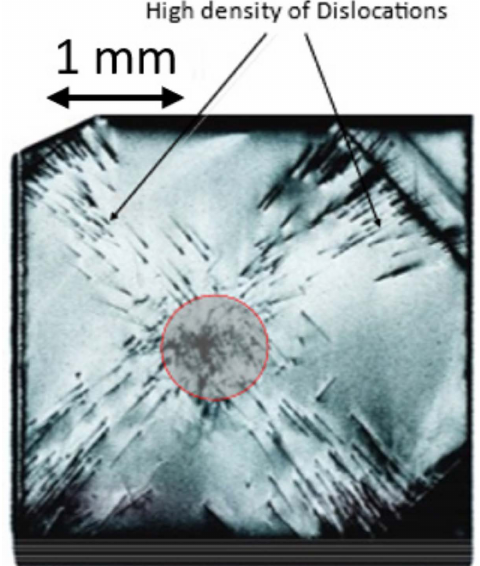
Figure 4. The X-ray topographic image of an HPHT type 1b single crystal diamond taken from the paper of Shikata [42]. The high density of dislocations is visible along the <111> and <112> directions. In the centre of the crystal, a circular region approximately 0.8 mm in diameter with a very high density of dislocations is visible. The size of the diamond plate is about 3 mm × 3 mm. The XRT image is taken in the (404) plane. Image is taken from ref. [42]: Shikata, S. Diamond dislocations analysis by X-ray topography. Funct. Diam. 2022 , 2 , 174. Reprinted by permission of Taylor & Francis Ltd, http://www.tandfonline.com (accessed on 1 February 2023) on behalf of Zhengzhou Research Institute for Abrasives & Grinding Co.,